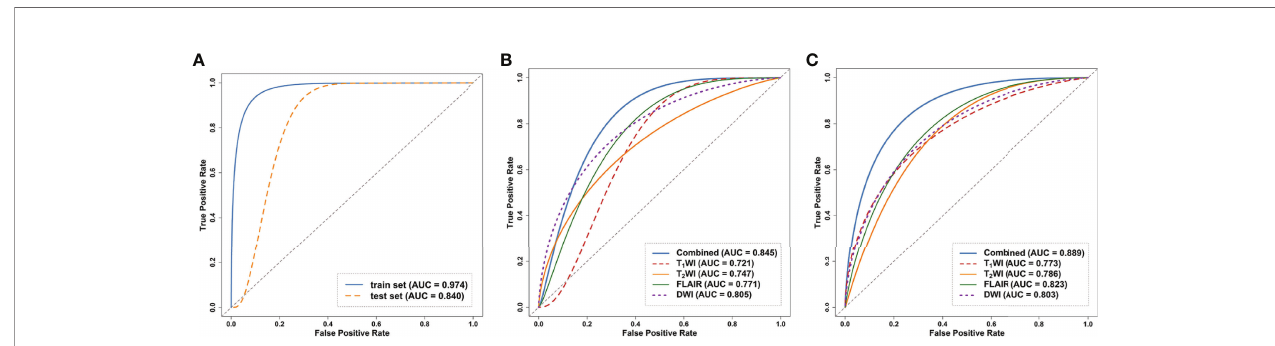
FIGURE 4 | Receiver operating curves (ROC) of the models on the internal test dataset. (A) ROC of clinical model on the train and test dataset. (B) ROC curves of DL models trained on the four single sequences (T 1 WI/T 2 WI/FLAIR/DWI) and combined sequence. (C) ROC curves of the radiomics models trained on the four single sequences and combined sequence. ROC, receiver operating characteristic curve; DL, deep